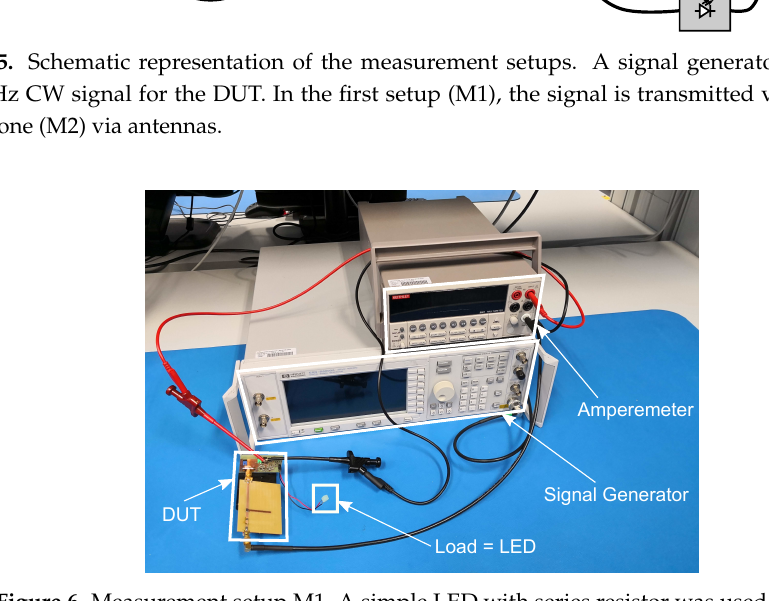
Figure 6. Measurement setup M1. A simple LED with series resistor was used as